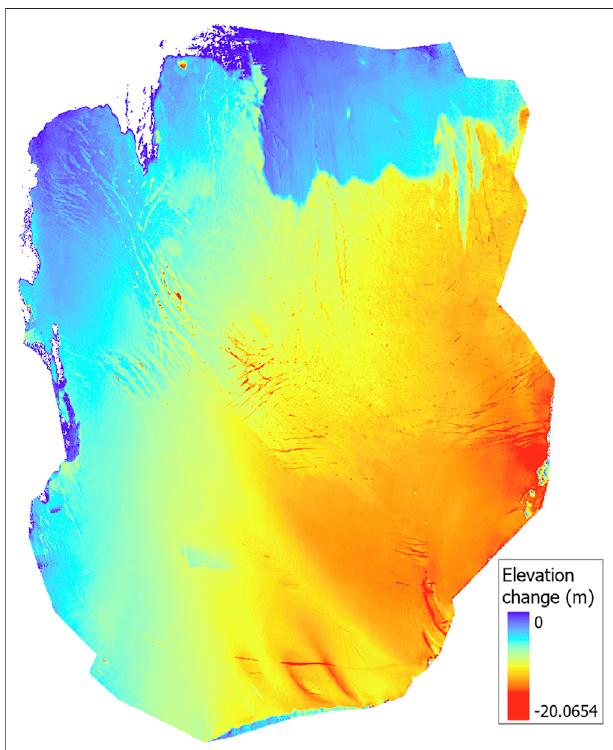
FIGURE 2 | Surface elevation change of the Sholes Glacier between August 17, 2020 and September 5, 2020. The DEMs for each survey date were differenced to reveal the surface elevation change.